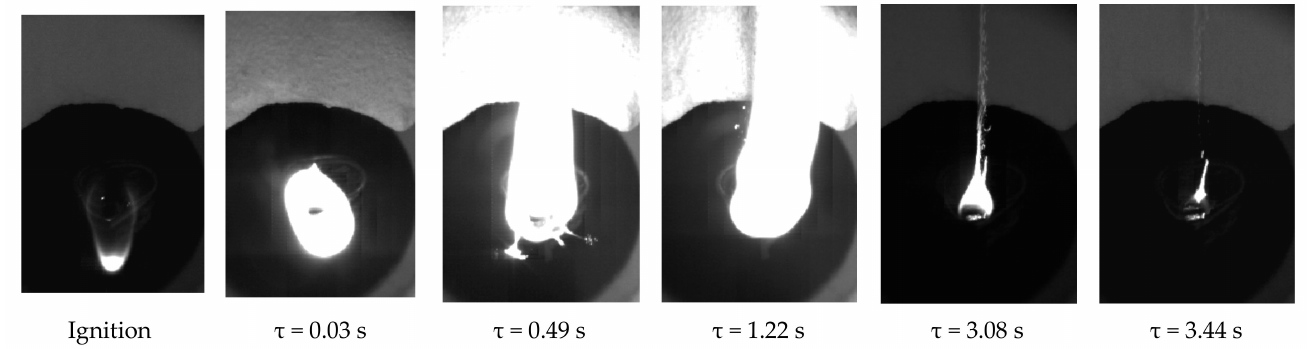
Figure 13. Video frames of the drop ignition and subsequent combustion of liquid hydrocarbons at T g = 700 ◦